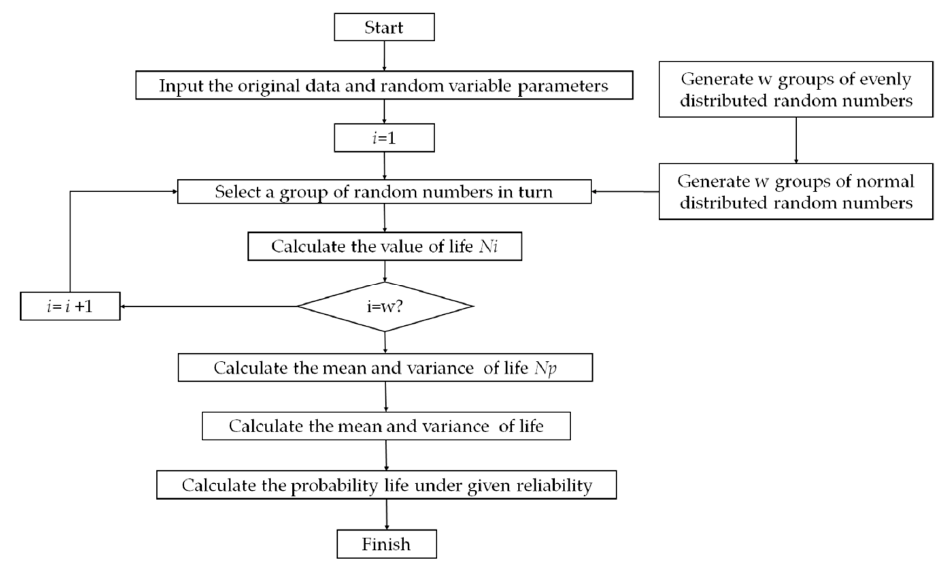
Figure 9. Flowchart of probabilistic life prediction by Monte Carlo simulation.